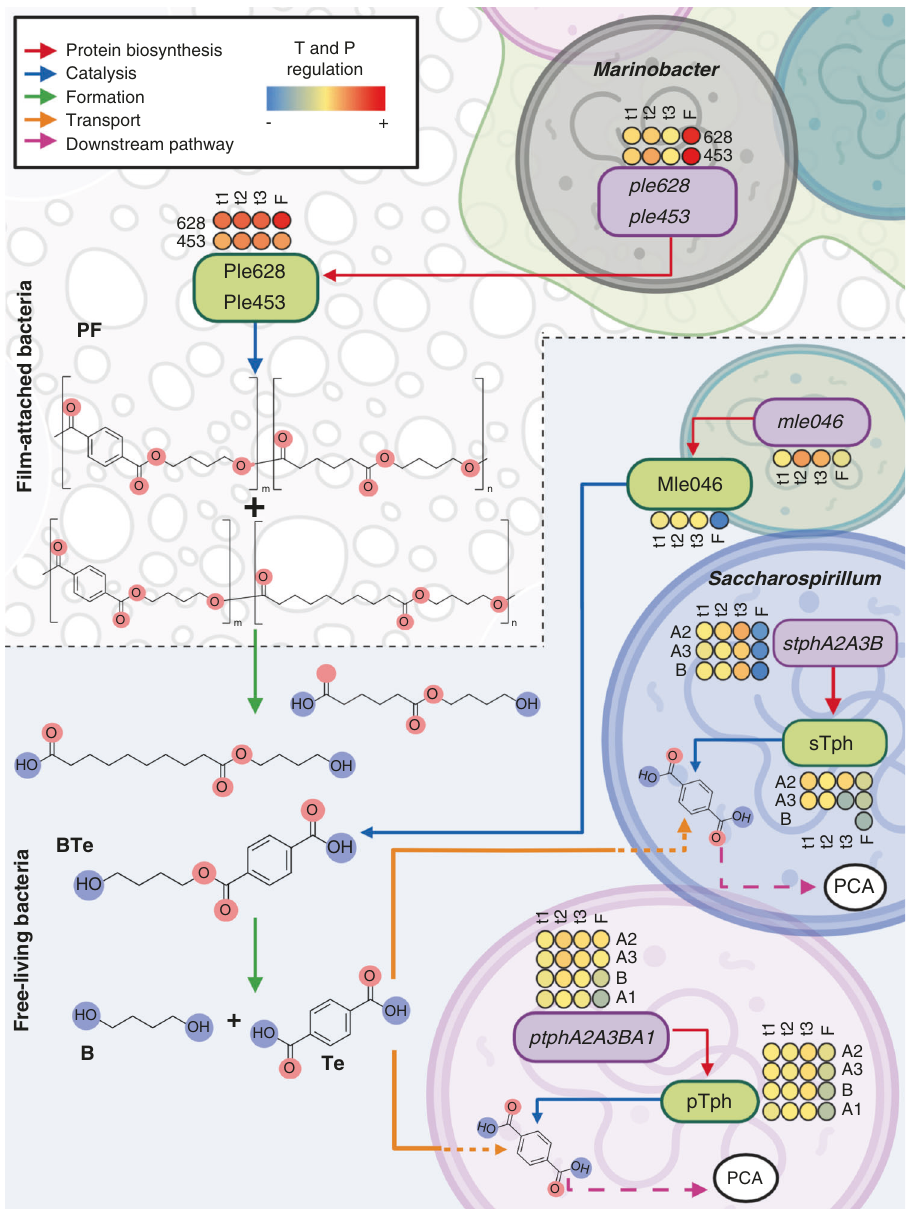
Fig. 6 Integration of multi-omics data. Proposed mechanisms for the synergistic biodegradation of a PBAT-based blend fi lm (PF) during different time points (t1 – t3) and within a bio fi lm (F). Periplasmatic α / β hydrolases (Ple628, Ple453), synthesized by Marinobacter , hydrolyze PF to produce oligomers and monoesters of 1,4-butanediol (B) with either terephthalic acid (Te) or sebacic acid (Se)/adipic acid (Ad). An Alphaproteobacterial Mle (Mle046) hydrolyzes a mixture of terephthalate-butanediol monoester (BTe) to produce Te and B. Te is transported into the cell and catabolized by terephthalate degradation clusters of an unknown bacterium (pTPD), and to a lesser extent by Saccharospirillum (sTPD). Downstream degrading genes leads to the formation of protocatechuate (PCA). Red arrows indicate gene translation into a functional protein; blue arrows indicate the catalysis of a substrate by a protein; green arrows, show the formation of intermediates by the catalysis of a substrate; orange arrows represents the transport of intermediates from the surroundings to bacteria; pink arrows represent donwstream degradation pathways. The color scale represent upregulated ( + ) and downregulated ( − ) transcripts (T) and proteins (P) (created with